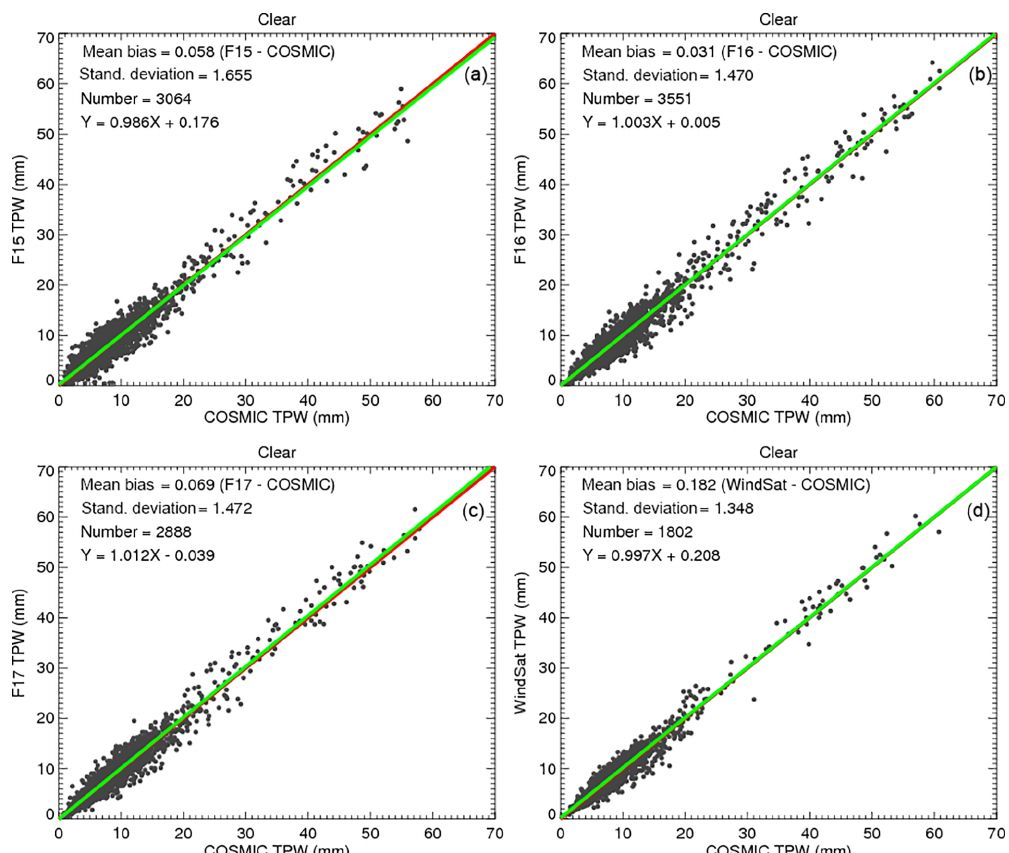
Figure 2. TPW scatter plots for the COSMIC and RSS version 7.0 pairs under clear conditions for (a) F15, (b) F16, (c) F17, and (d)